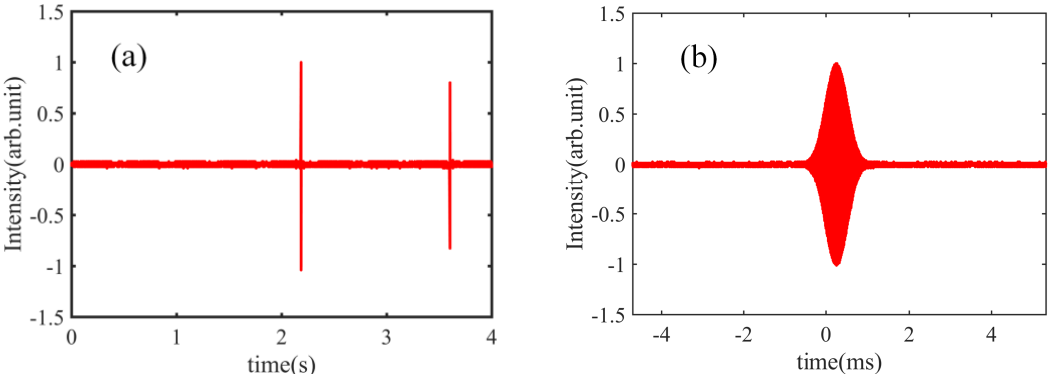
Figure 3. ( a ) Cross-correlation patterns corresponding to the reference mirror and the measurement mirror, without water in the container; ( b ) detailed observation of the cross-correlation pattern, without water in the container.